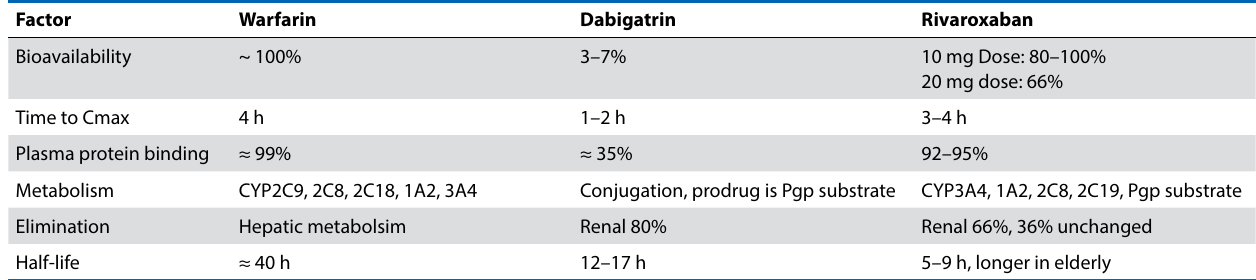
Table I. Summary of the pharmacokinetics of warfarin, dabigatrin and rivaroxaban